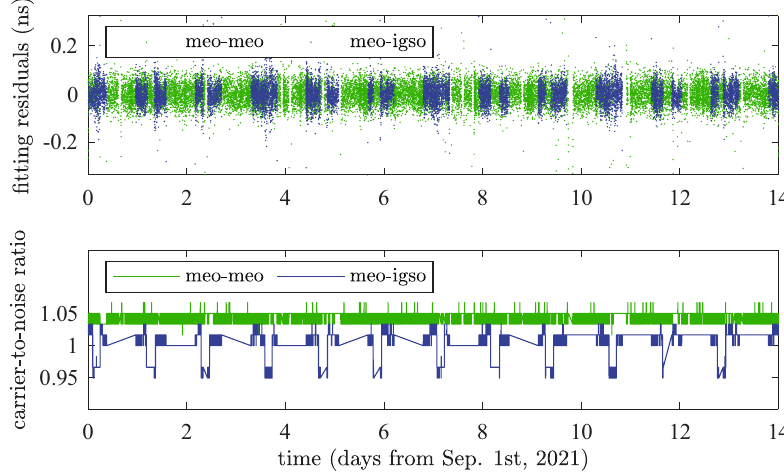
Figure 6: Measurement noise and normalized carrier - to - noise ratio of BDS dual one - way